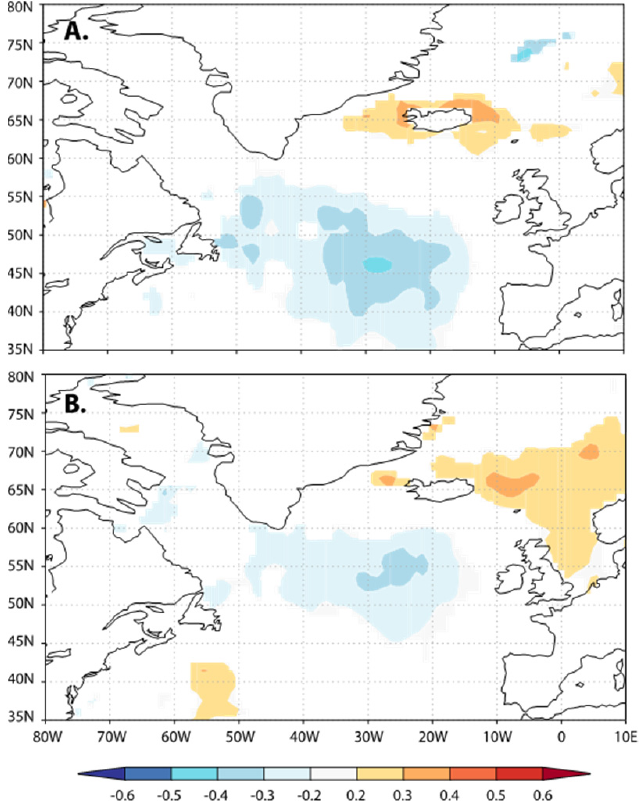
Figure 2. Field correlations between the Scandinavian fire record and sea surface temperatures (SST) in the Northern Atlantic for spring (March through May, A ) and summer (June through August, B ). The fire chronology was correlated with each grid-cell SST chronology over the given geographical extent. The areas with significant correlation ( p < 0.10) are colored. The value and direction of correlation are shown by the color scale.